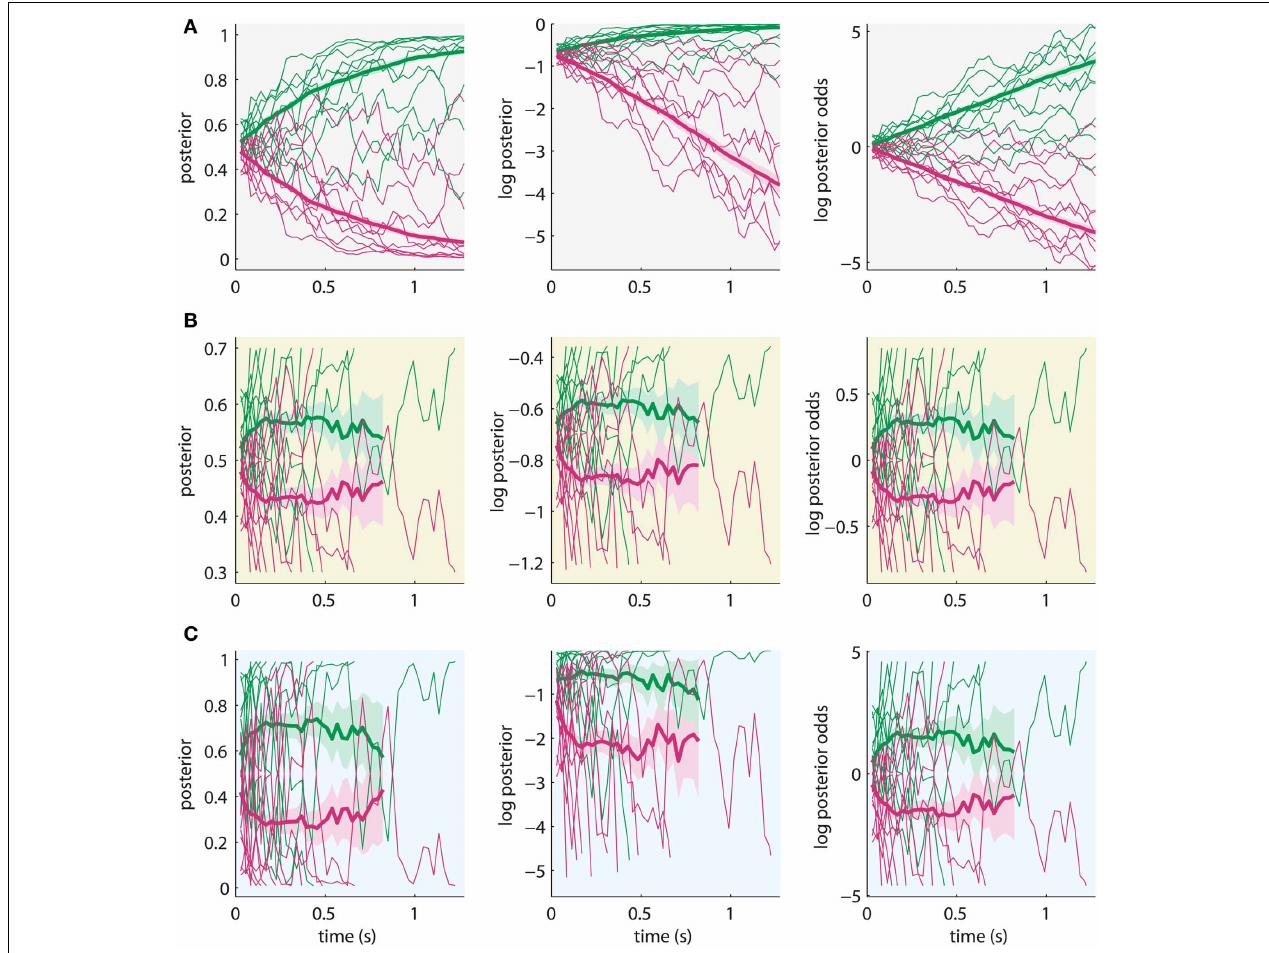
differentiated based on asymptotic behavior. (B) Sample trajectories (thin lines) are only plotted until crossing a bound and averages (thick lines) are based only on data points before crossing the bound. Rescaling is applied to account for unknown scaling of neural correlates of the decision variables. Note that standard errors of averages increase with time because fewer trials contribute data at later time points.